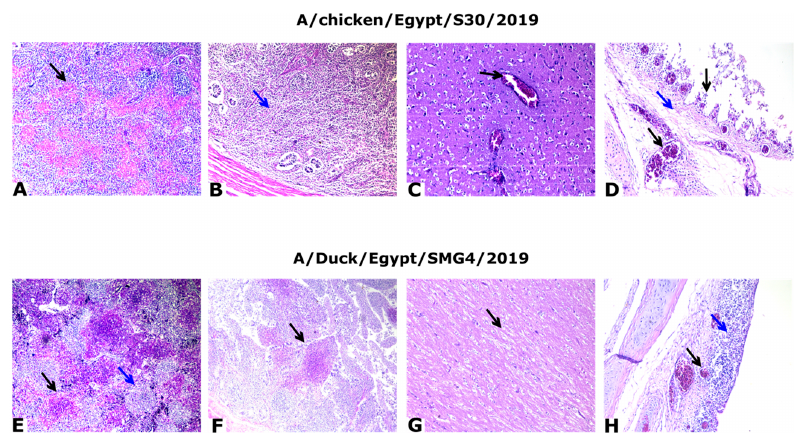
Figure 5. Histopathology slices from the tissue of infected chickens. ( A ) Spleen of A/chicken/Egypt/S30/2019(H5N8) at 2 dpi showing severe multifocal necrotic tissue (black arrow); H&E, ×100. ( B ) Cecal tonsils at 2 dpi showing mild depletion of lymphocytes (star); H&E, ×100. ( C ) Cerebrum of control positive at 3 dpi showing congested blood vessels (black arrow); H&E, ×200. ( D ) Trachea of control positive at 2 dpi showing sloughed epithelium, edema (blue arrow), and congested blood vessels in lamina propria (black arrow); H&E, ×200. ( E ) Spleen of A/Duck/Egypt/SMG4/2019(H5N8) at 2 dpi show- ing severe depletion of lymphocytes (blue arrow) with multifocal necrotic areas (black arrow); H&E, ×100. ( F ) Cecal tonsils at 2 dpi showing multifocal necrotic patches (black arrow); H&E, ×100. ( G ) Cerebrum at 2 dpi showing demyelination (black arrow); ×200. ( H ) Trachea at 2 dpi showing thickening of the wall of the mucosal layer due to congested blood vessels (black arrow), edema, and mononuclear cell infiltration (blue arrow); H&E, ×200.